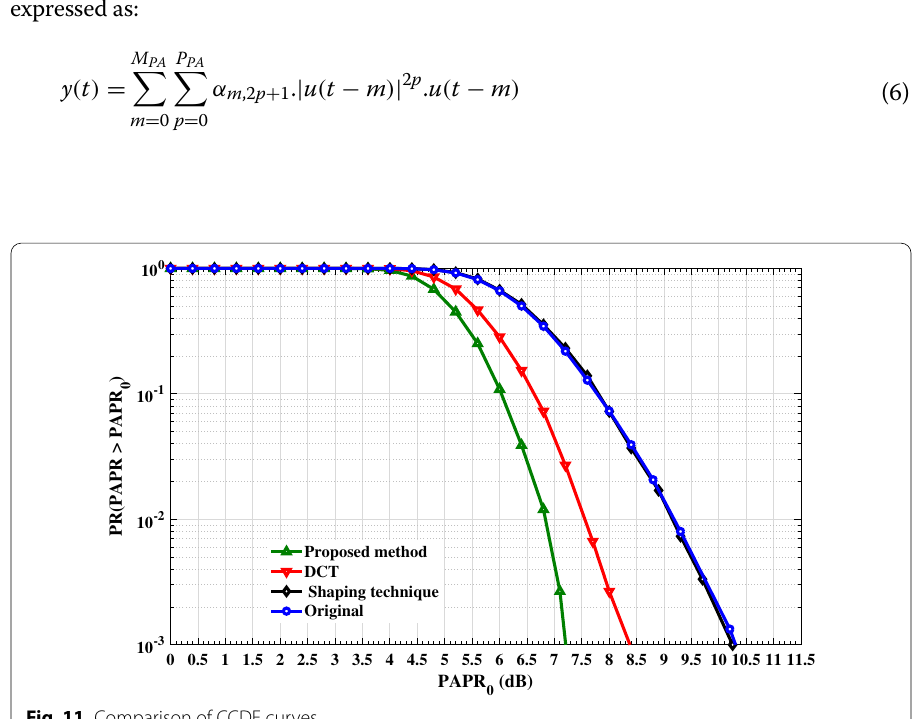
Fig. 11 Comparison of CCDF